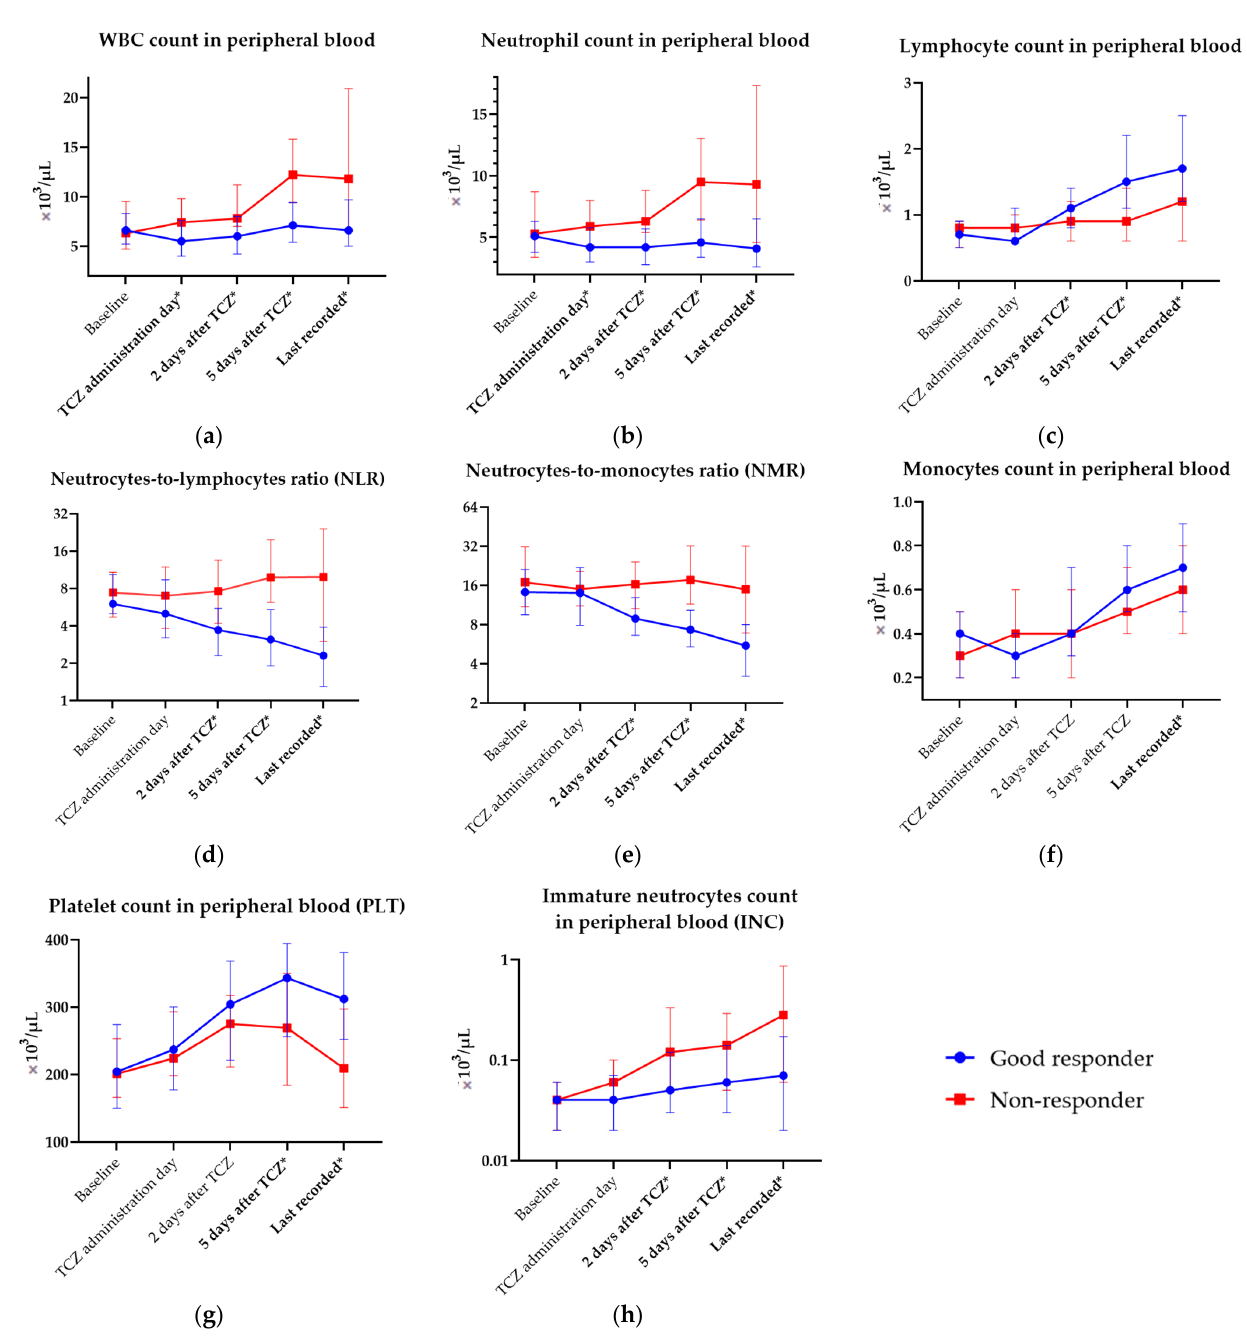
Figure 3. Selected aberrations in complete blood count (CBC) and complex indices measured throughout hospitalization in clinical (good) responders and non-responders. Statistically signi fi cant di ff erences are bolded and marked with *. ( a ) White blood cell count (WBC, × 10 3 /µL); ( b ) neutrophil count in peripheral blood ( × 10 3 /µL); ( c ) lymphocyte count in peripheral blood ( × 10 3 /µL); ( d ) monocyte count in peripheral blood (×10 3 /µL); ( e ) neutrocyte-to-lymphocyte ratio (NLR); ( f ) neutrocyte-to-monocyte ratio (NMR); ( g ) platelet count in peripheral blood ( × 10 3 /µL); ( h ) immature neutrocyte count in peripheral blood (INC, × 10 3 /µL). Points represent median values of variables and whiskers re fl ect interquartile ranges (IQR).